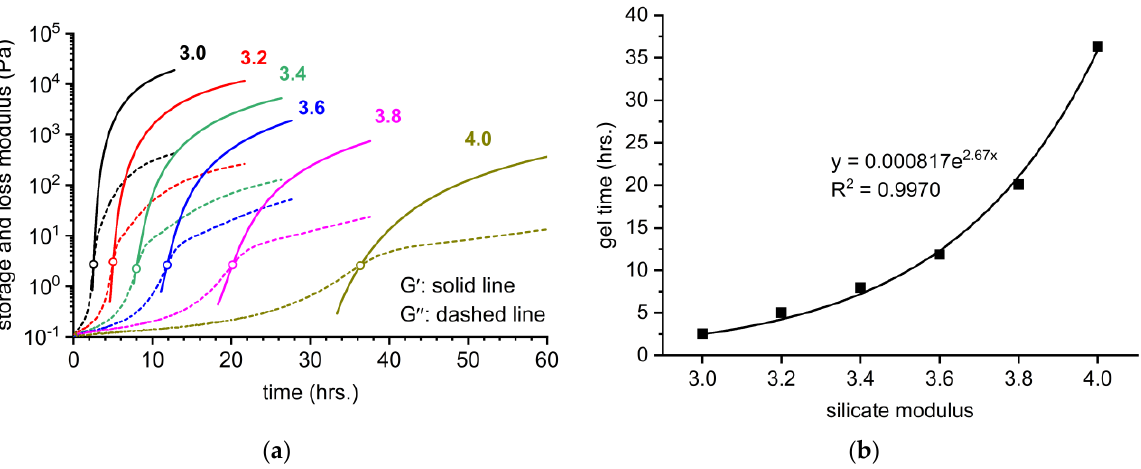
Figure 3. ( a ) Continuous monitoring of the gelation process of lithium silicate densifiers with differ- ent silicate moduli. The open circles highlight the gel point, in which G′ = G″; ( b ) Exponential fit of the time needed to reach the gel point plotted against the silicate modulus of densifiers.